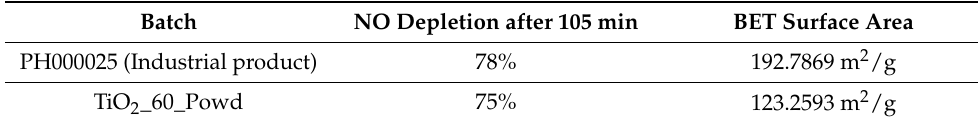
Figure 7. Percentage of residual NO concentration provided by sample TiO 2 _60_Powd, compared with a commercially available industrial product. Table 5. BET surface area of sample TiO 2 _60_Powd, compared with the commercially available industrial product PH000025, and percentage of NO depletion provided by sample TiO 2 _60_Powd, compared with the